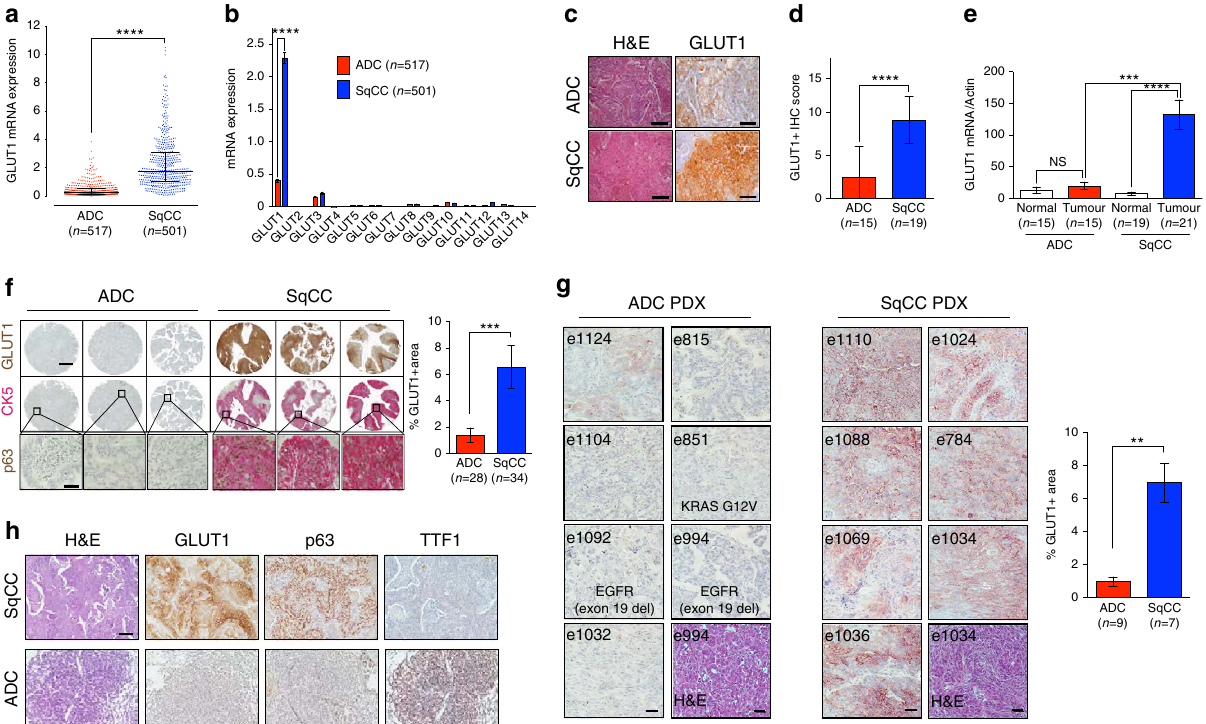
Figure 1 | GLUT1 is highly expressed in lung SqCC compared to lung ADC. ( a ) Comparison of GLUT1 expression between 517 ADC and 501 SqCC tumour samples from the TCGA mRNA sequencing data (10 4 normalized transcripts per million mappable read (TPM)). Error bars represent the median ± quartile range, Mann–Whitney u -test, **** P o 0.0001. ( b ) Expression of all GLUT isoform mRNA (10 4 normalized transcripts TPM) in TCGA ADC and SqCC tumour samples. Mann–Whitney u -test, **** P o 0.0001. ( c , d ) Representative IHC images and quantification of GLUT1 expression in human patient clinical samples of ADC and SqCC. **** P o 0.0001. ( e ) Comparison of GLUT1 mRNA expression from human NSCLC tumour samples and matched normal lung tissue samples. **** P o 0.0001, *** P o 0.001. ( f ) Representative IHC images of GLUT1, CK5 and p63 expression in human ADC and SqCC tissue microarray tumour cores (left). Low-magnification scale bar, 300 m m; high-magnification scale bar, 50 m m. Quantification of GLUT1-positive staining in ADC and SqCC microarray samples (right). *** P o 0.001. ( g ) Representative IHC images (left) and quantification (right) of GLUT1 expression in SqCC patient-derived xenograft tumours compared to ADC patient-derived xenograft tumours. ** P o 0.01. ( h ) Representative GLUT1, p63 and TTF1 IHC images of KL ADC and SqCC tumours. Scale bars, 200 m m. All error bars represent the mean ± s.e.m., and two-tailed t -test was used unless noted otherwise. All scale bars, 50 m m unless otherwise noted. NATURE COMMUNICATIONS|8:15503|DOI: